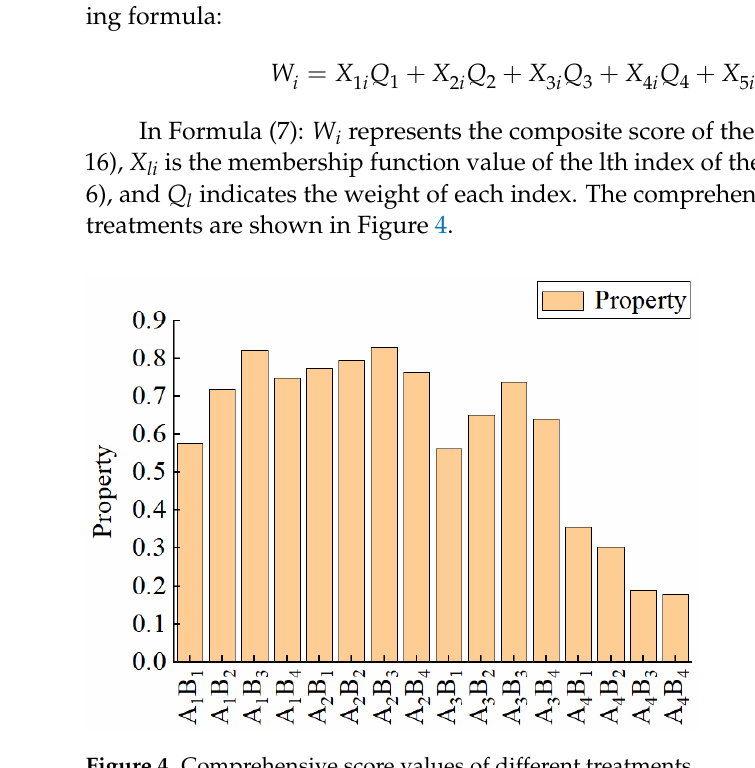
Figure 3. Membership function value of each treatment.